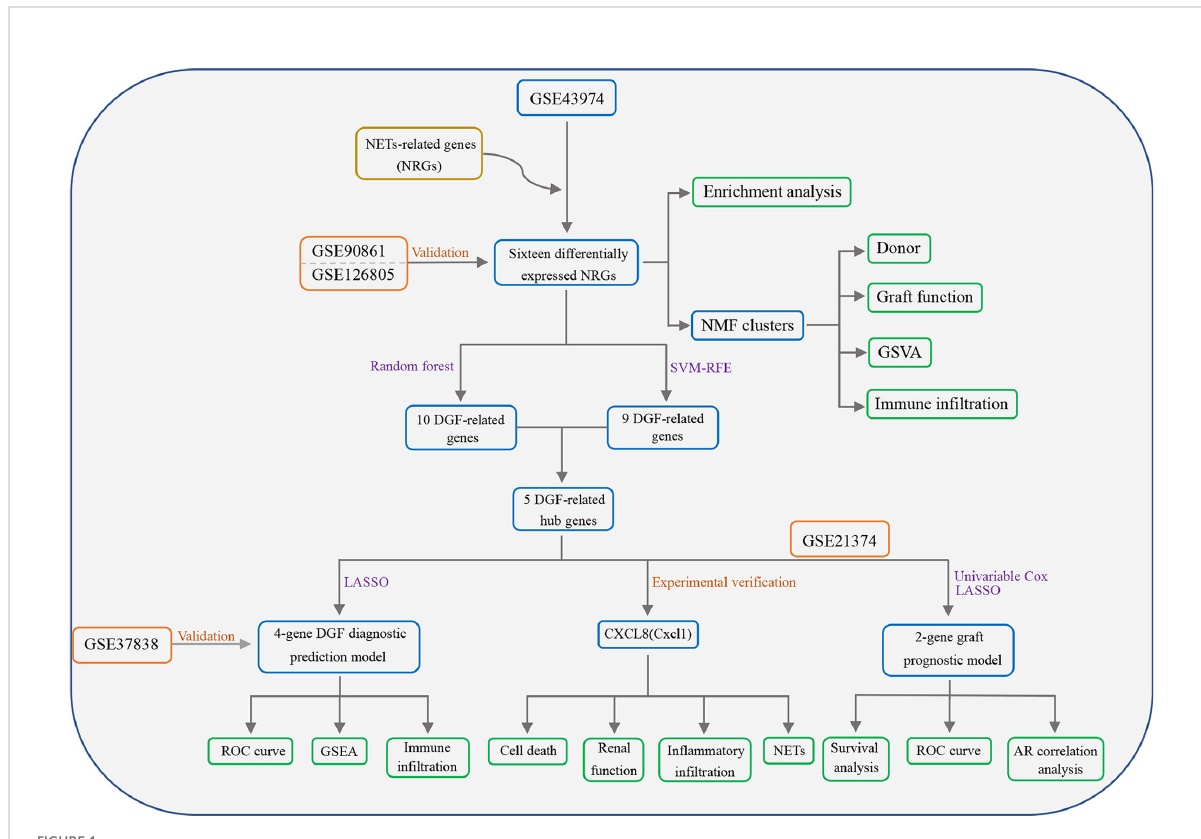
FIGURE 1 Flowchart of this study. NETs, Neutrophil extracellular traps; NRGs, NET-related genes; DGF, delayed graft function; GSVA, gene set variation analysis; SVM-RFE, support vector machine recursive feature elimination; LASSO, least absolute shrinkage and selection operator; ROC, receiver operating characteristic; GSEA, gene set enrichment analysis; AR, acute